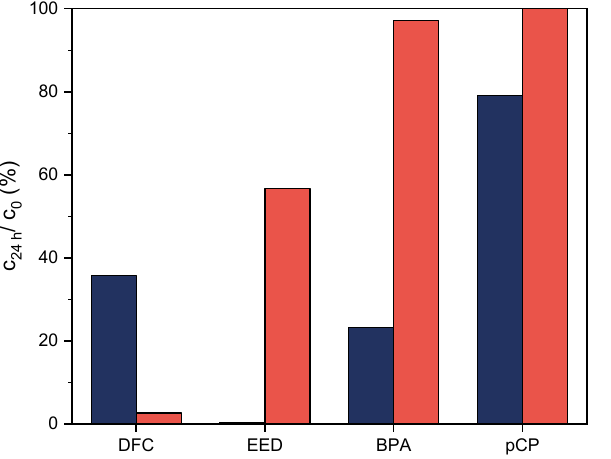
Figure 8. Residual concentration of model substances after 24 h degradation by F2 under Fenton conditions in citrate buffer at pH 4.5 (blue) and water at pH 7 (red).